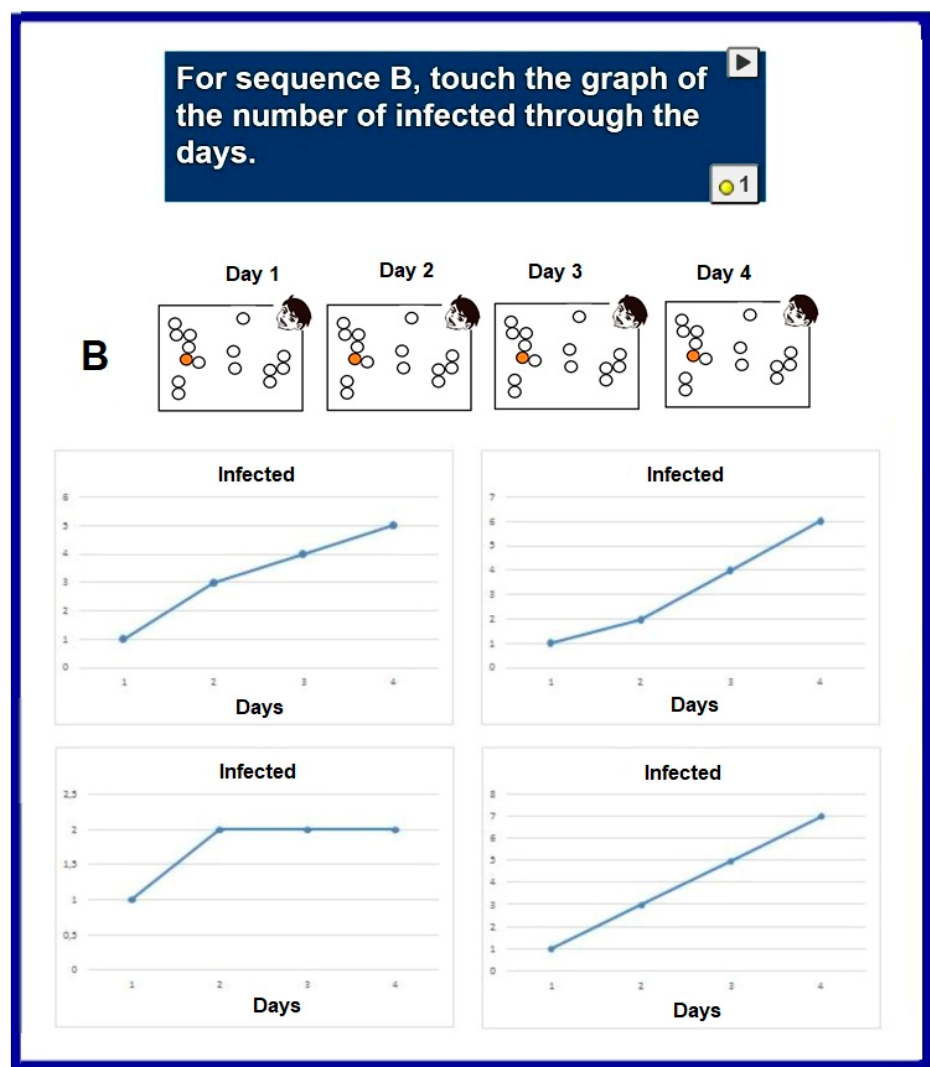
Figure 16. Example of a question that tested whether students understand the pool table model representing transmission across different days and are able to plot it.